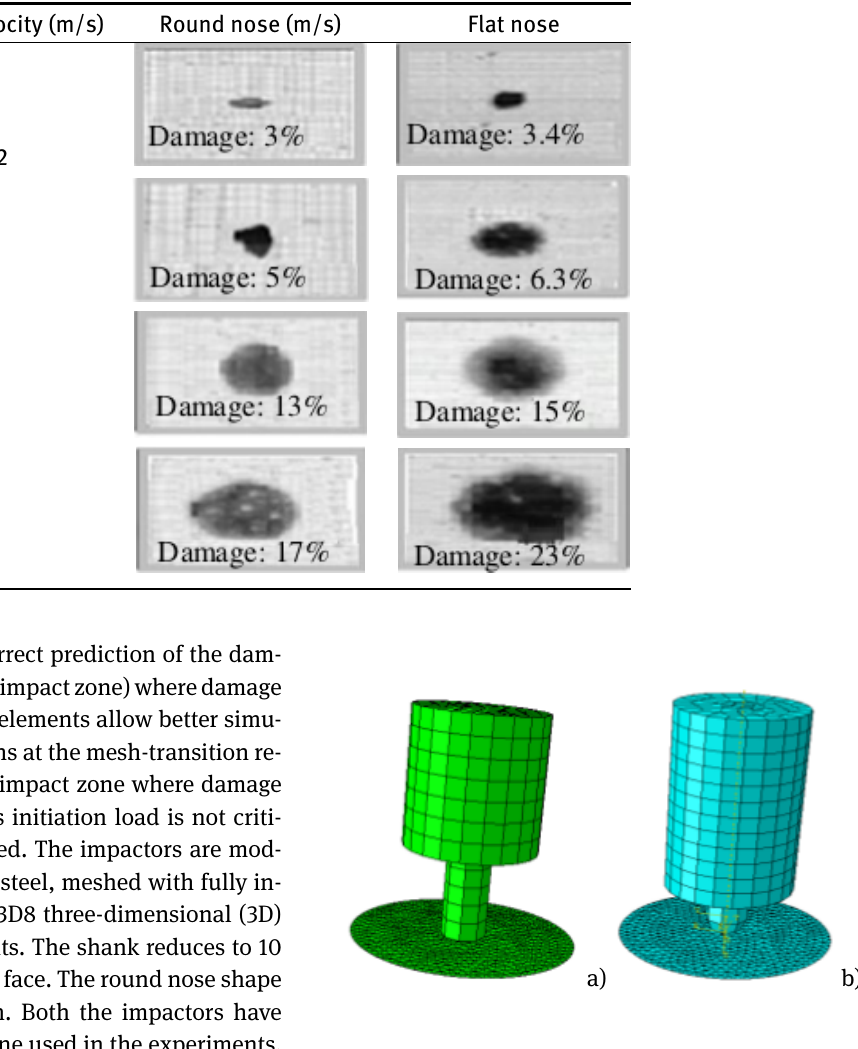
Figure 14: Simulation produced model and legend table: a) flat nose b) round nose.